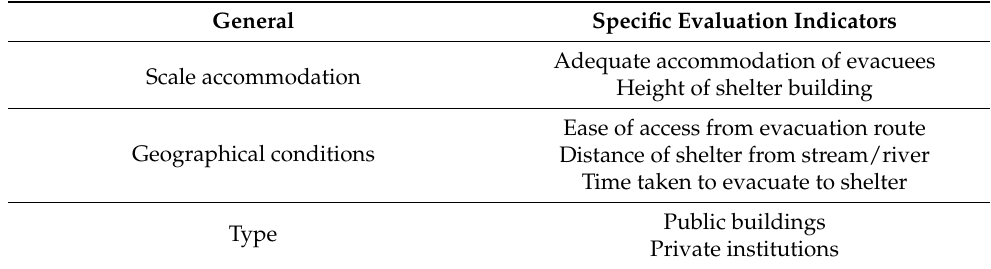
Table 1. Optimal shelter evaluation